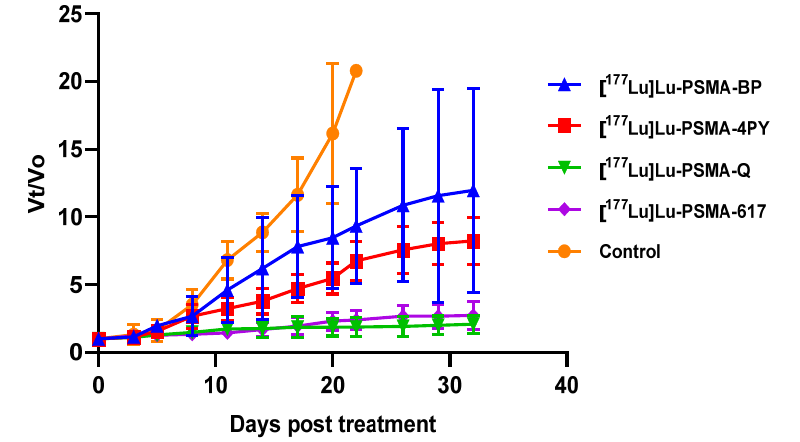
Figure 8. Tumor growth curves of mice in different groups. On the day at the end of the entire treatment experiment (Day 32), the survival rates were 80% ([ 177 Lu]Lu-PSMA-Q), 60% ([ 177 Lu]Lu-PSMA-617), 50% ([ 177 Lu]Lu-PSMA-4PY), 20% ([ 177 Lu]Lu-PSMA-BP) and 0 (control), respectively. The survival time of the mice in each treatment group was significantly longer than that of the control group ( p < 0.01) (shown in Figure